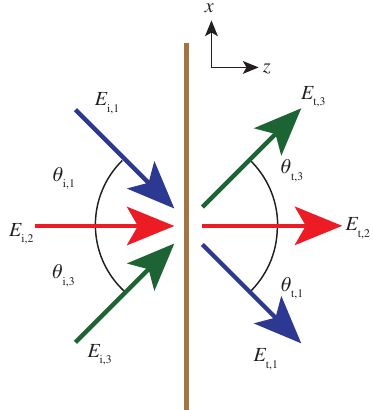
Figure 6: Multiple scattering from a uniform bianisotropic reflec- tionless